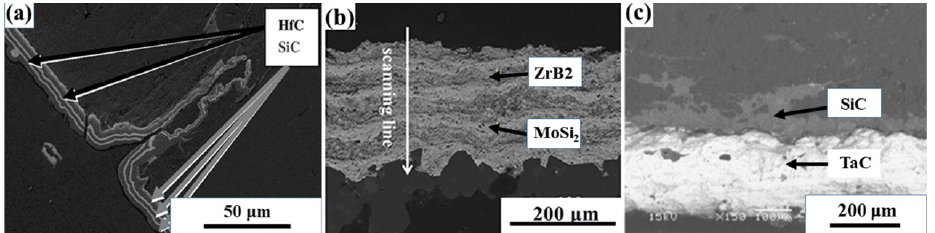
Typical morphologies of the single UHTC/silicide multilayer coatings: CVD-HfC/SiC coated C/C [305] (a), PS–ZrB 2 /MoSi 2 coated C/C [335] (b), and PC+PS TaC/SiC coated C/C [338] (c). Reproduced with permission from Ref.